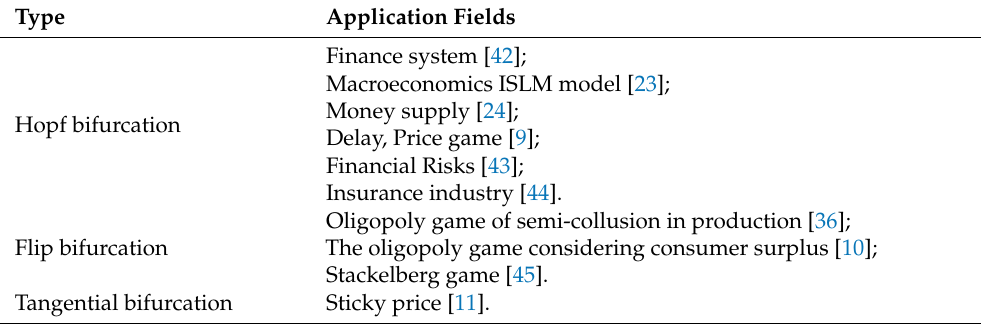
Table 3. Types of Table 3. Types of bifurcation.